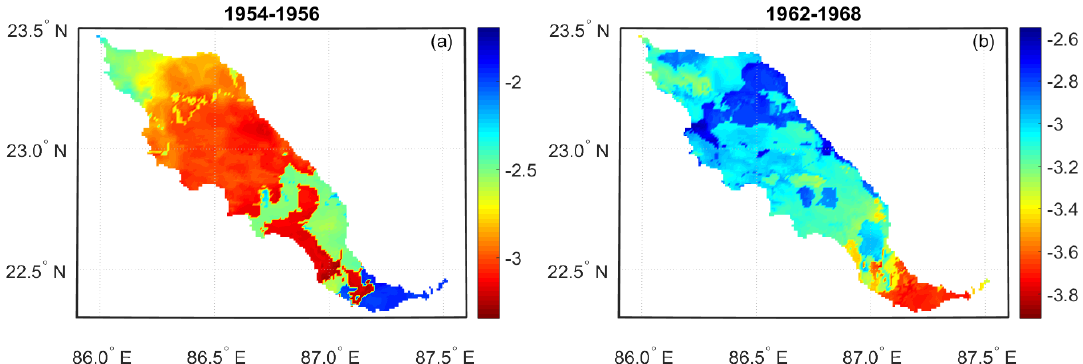
Figure 8. Various events of major droughts ( a , b ) of at least two years of duration observed in the Kansabati Region from 1950 to 2016. Each plot shows the averaged value of scPDSI over the drought period. The scalebar represents corresponding scPDSI units.